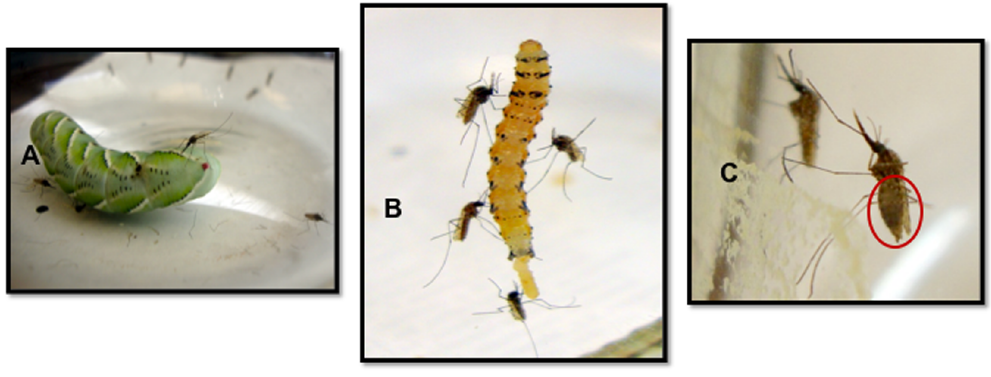
Figure 3. Images show females that had been attracted to, and landed upon for feeding: A. A fourth instar Manduca sexta , larva; B. A fourth instar Heliothis subflexa larva. C . An An. stephensi female is shown (foreground) that has engorged on the haemolymph of a Manduca sexta